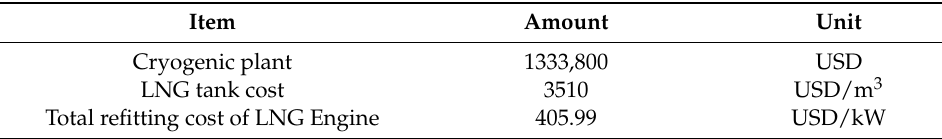
Table 8. Refit and installation costs of LNG